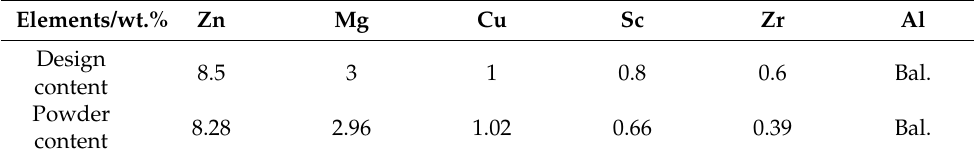
Table 1. The composition of AlZnMgCu(Sc,Zr) powder. Elements/wt.%